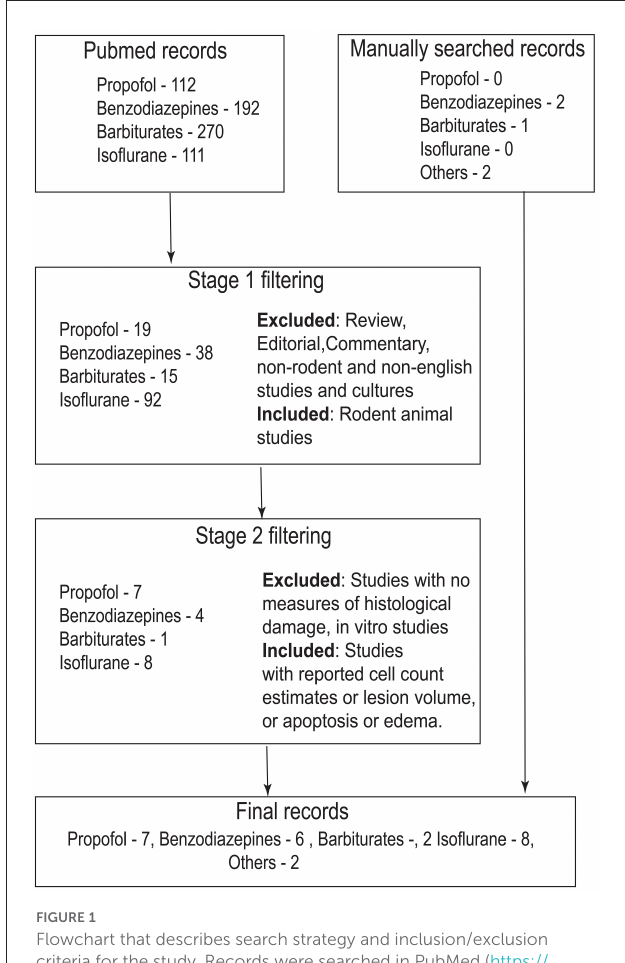
FIGURE1 Flowchart that describes search strategy and inclusion/exclusion criteria for the study. Records were searched in PubMed (https:// pubmed.ncbi.nlm.nih.gov/) using the search term “traumatic brain injury” + drug name (For example, the search term for propofol would be traumatic brain injury propofol). In stage 1, abstract of the records were screened. Only rodent animal studies were included in this stage. Non-rodent studies, reviews, commentaries, editorials and non-English articles were excluded. In stage 2, full text of the articles were screened according to the inclusion criteria mentioned in the figure. Records that have passed through stage 2 filtering along with manually cross-referenced records were included in the manuscript.